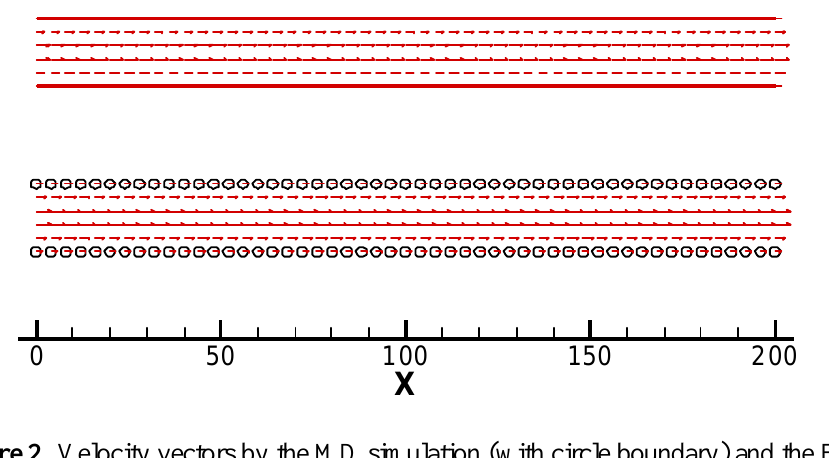
Figure 2. Velocity vectors by the MD simulation (with circle boundary) and the